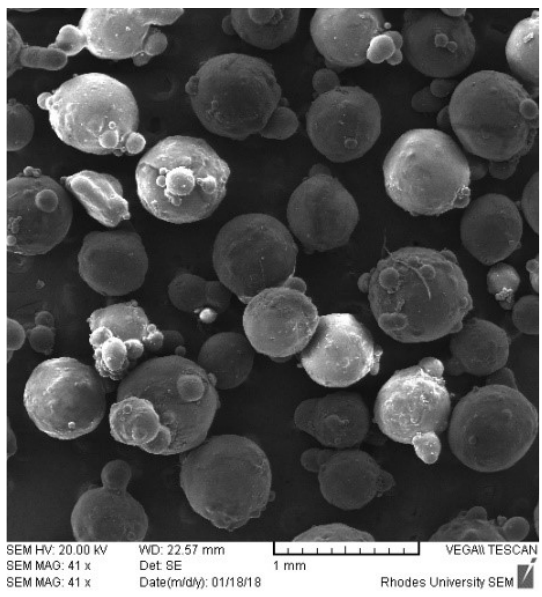
Figure 8. SEM image of RIF microspheres. Table 9. ANOVA data for response surface quadratic model (partial sum of squares—Type III) for % RIF released at 0.5